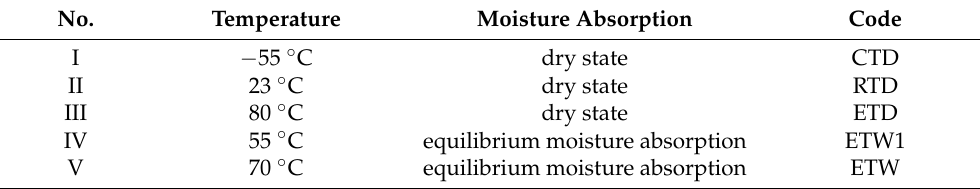
Table 1. Working conditions considered in the mechanical property